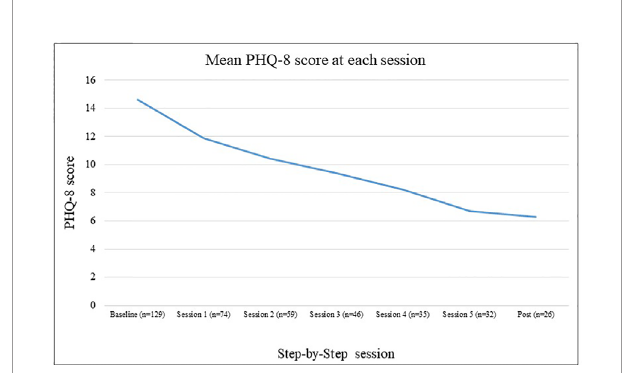
PHQ-8, Patient Health Questionnaire depression scale; WHODAS 2.0, WHO Disability Assessment Schedule; WHO-5, WHO-Five well-being Index; GAD-7, Generalized Anxiety Disorder scale; PSYCHLOPS, Psychological Problems and Outcomes, CI, Con fi dence